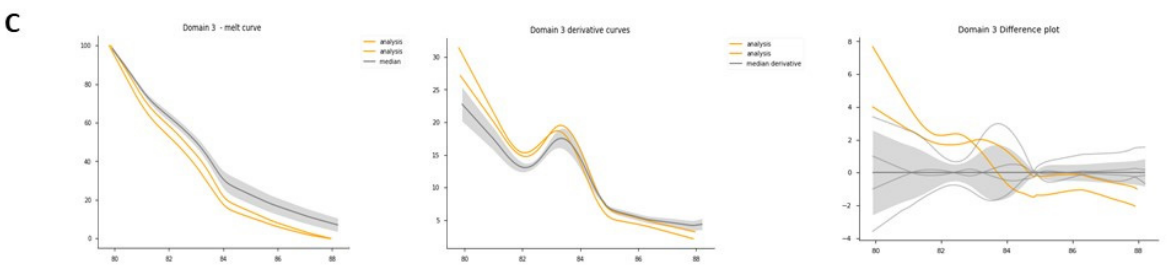
Figure 6. HRM domain analysis. HRM domain analysis for exon 1 of F8 : this experiment consisted of 1 patient as a positive control and 3 healthy controls. ( A ) All samples domain 1 analysis: from right to left: melt curve analysis plot: normalized melting curves of each sample are presented by domain. Derivative curves: identify the Tm between each domain. Differ- ence plot: the baseline for the difference plot construction consisted of a composite median reference curve (in gray) of all wildtype curves to facilitate clusters around the horizontal axis. ( B ) All samples domain 2 analysis. ( C ) All samples domain 3 analysis.